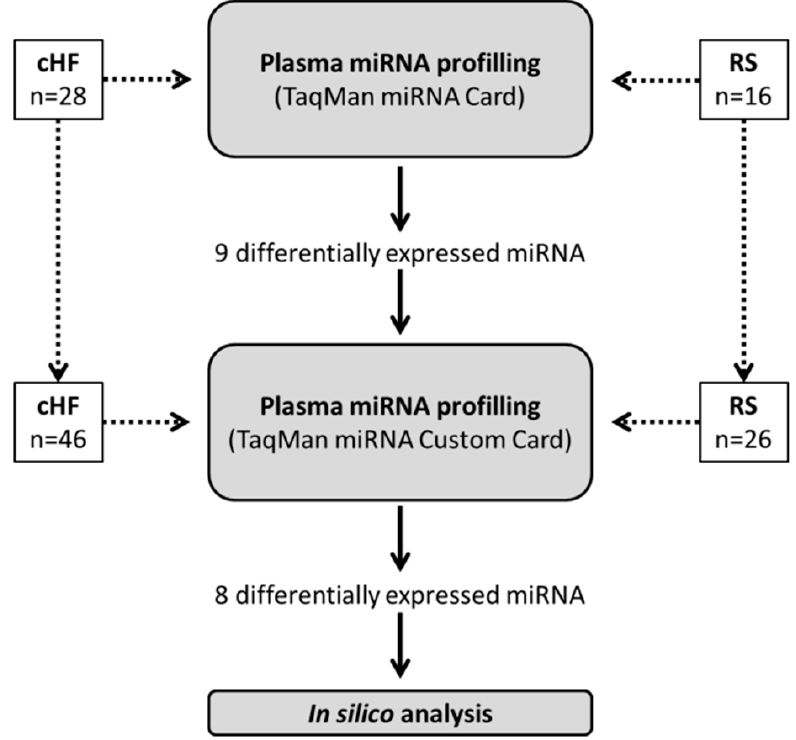
Figure 9. Schematic diagram of the study design. cHF: chronic heart failure; RS: reference subjects. The identified differential miRNAs were validated using the quantitative Low-density Custom TaqMan ® Array Advanced MicroRNA Cards in cHF patients ( n = 58). Table 6. Baseline characteristics of cHF patients and reference subjects in the miRNA validation .